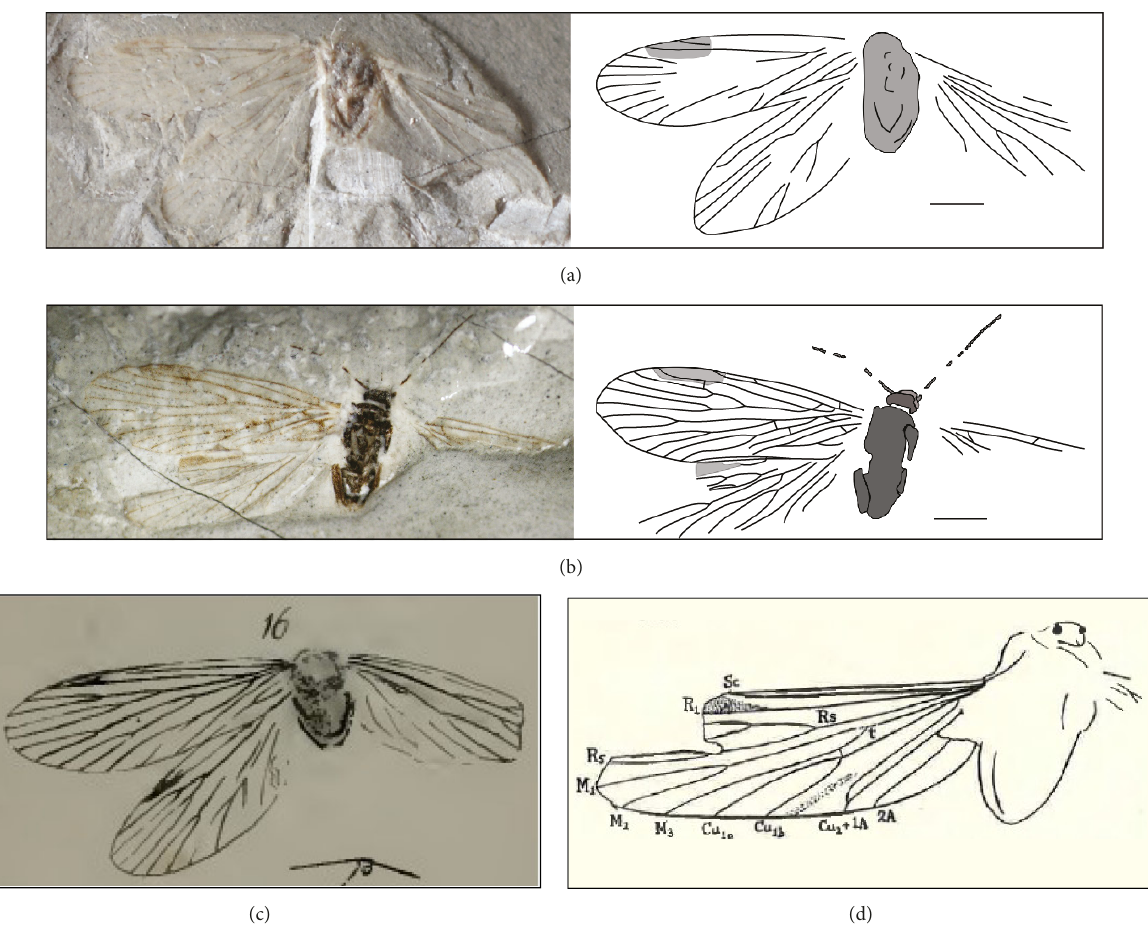
Figure 4: Holotype of Austaulius furcatus (Giebel, 1856) from Aust Cliff, Gloucestershire. (a) YORYM YM 815; (b) NHMUK I.11522;